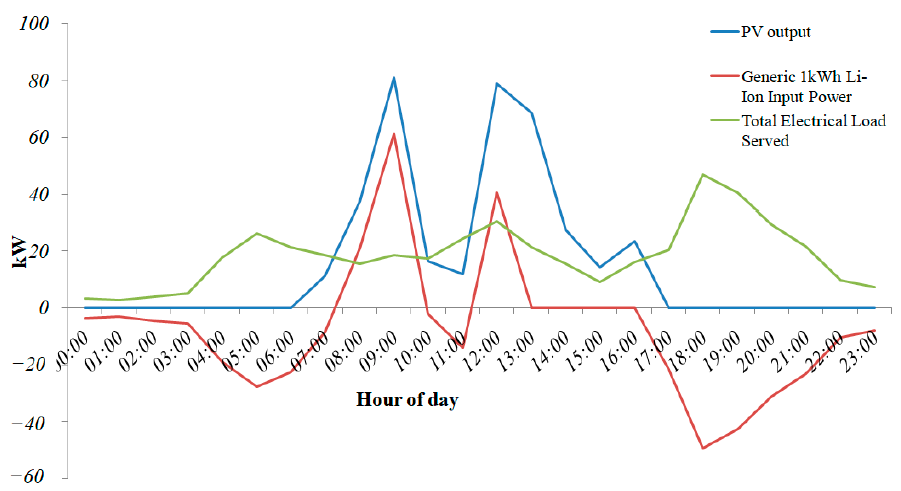
Figure 19. Time series plot of the electrical load served by PV–BSS configuration for 1 January.